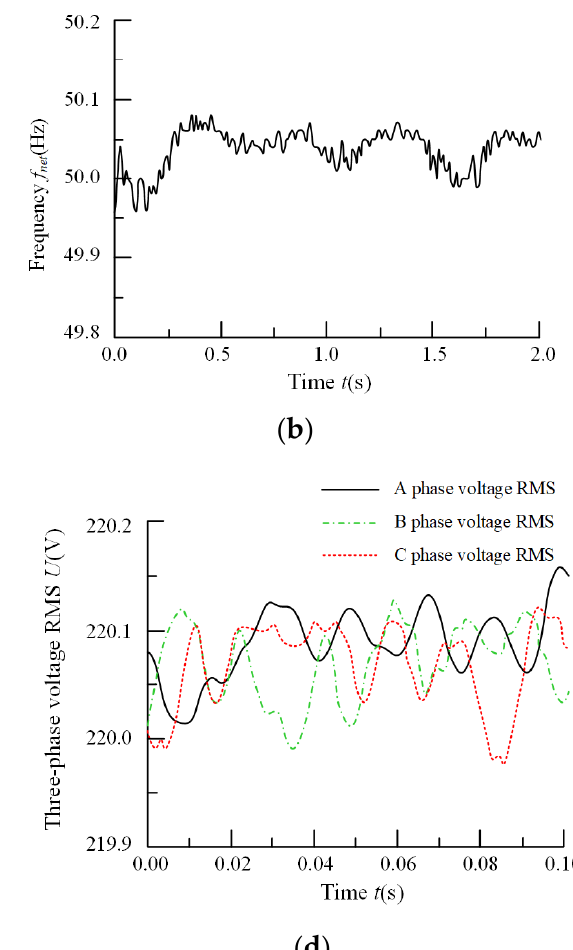
( b ) Grid side frequency. ( c ) Three-phase currents. ( d ) Three-phase RMS voltages.